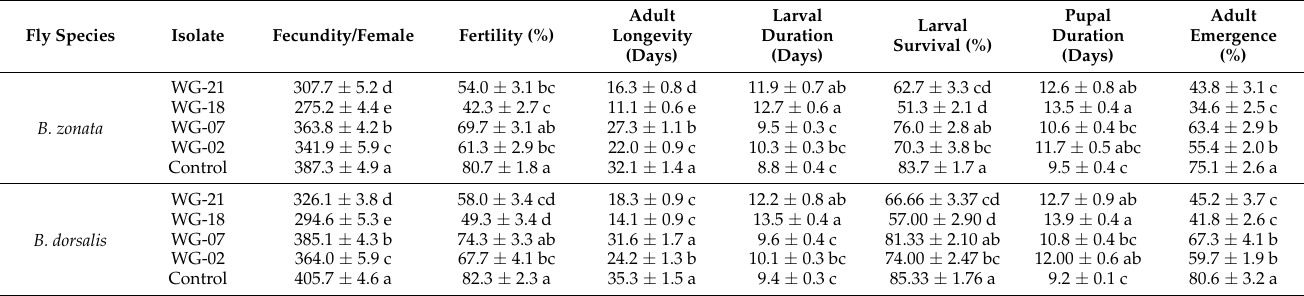
Table 8. Sub-lethal effects of four different isolates (WG-21, WG-18, WG-07, and WG-02) of entomopathogenic fungi tested at 1 × 10 4 conidia mL − 1 on the reproduction and development of Bactrocera zonata and B. dorsalis. Same letters within the column indicate no significant differences between isolates ( p < 0.05; Tukey HSD